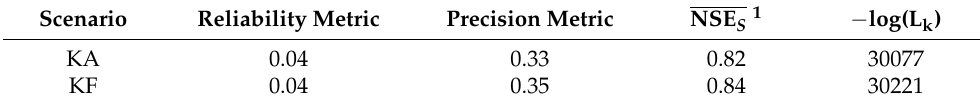
Table 3. Performance metrics and negative log-likelihood values of the two modeling scenarios.